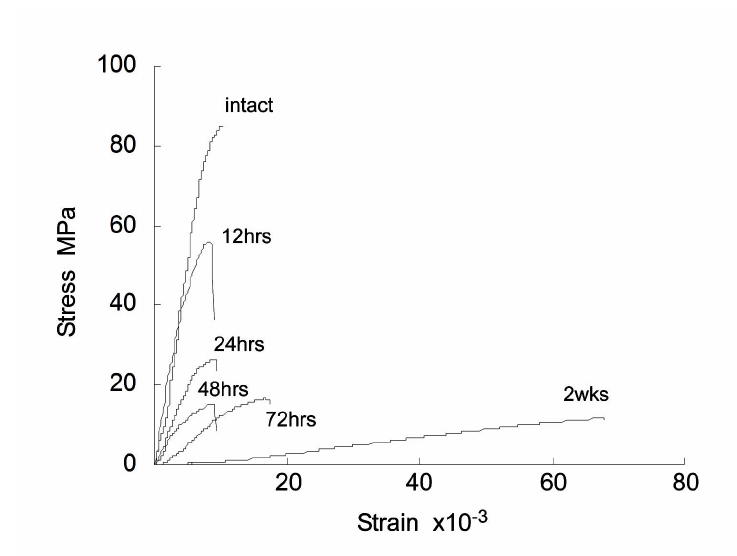
Fig. 4 Stress-strain curves for demineralized specimens at different immersion duration. The elastic moduli are obtained from the linear region of the curves and tensile strength are obtained from the maximum stress.